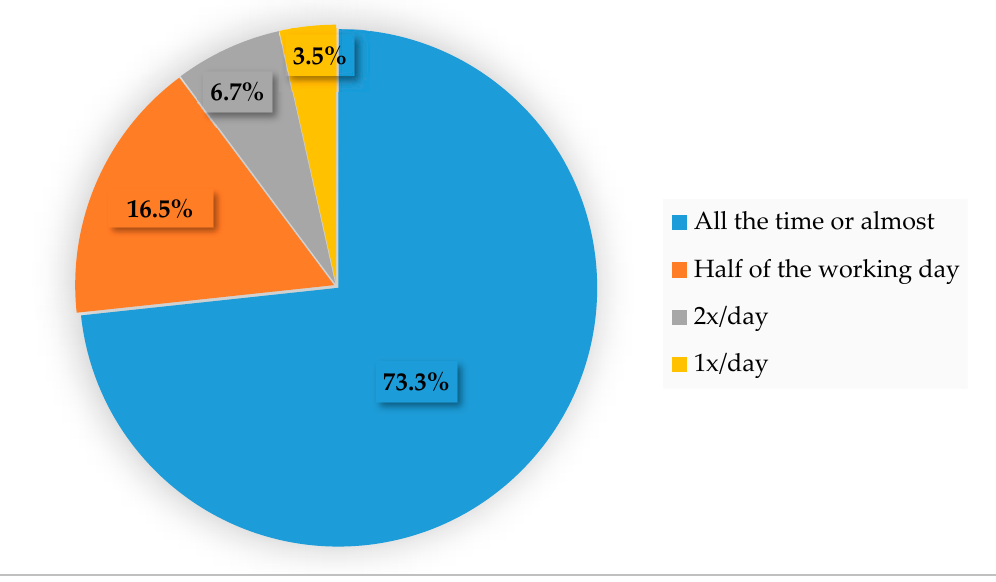
Figure 3. How often the breeding bitches were in contact with humans.